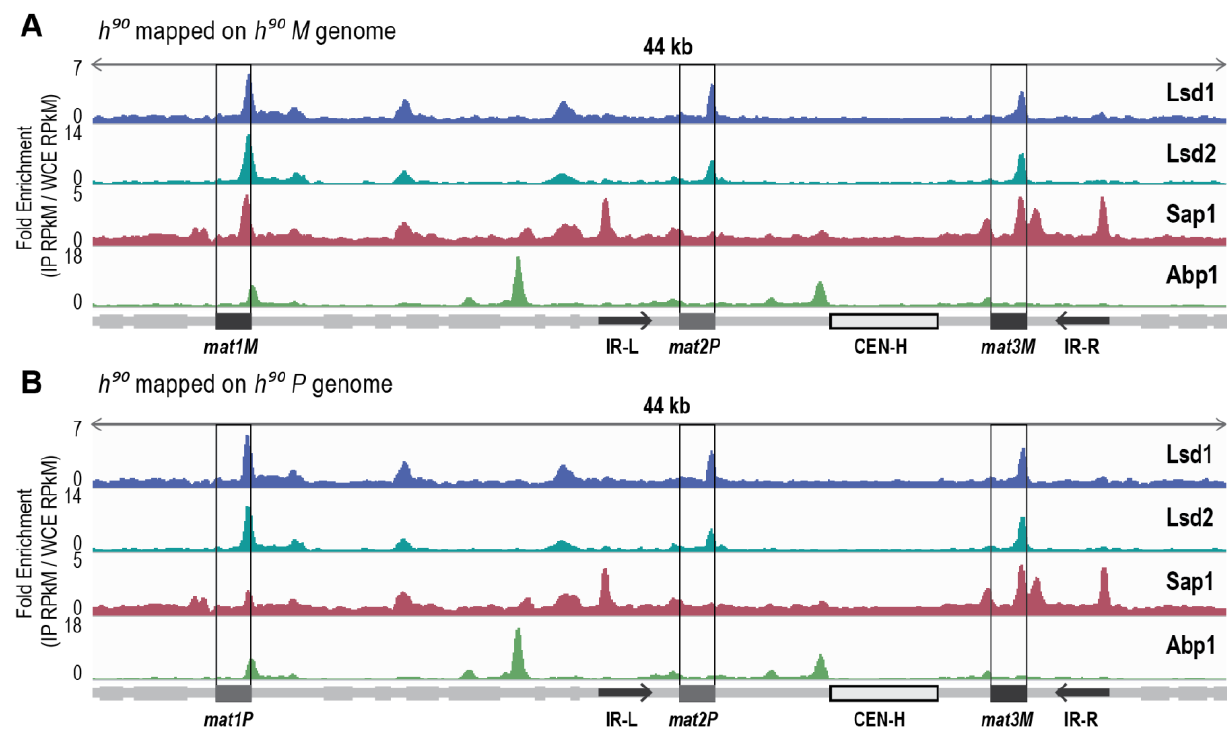
FIGURE 1: Lsd1, Lsd2, Sap1 and Abp1 are recruited to the mating type region. (A) Distribution of normalized enrichments of the Abp1, Lsd1, Lsd2, and Sap1 ChIPs in a h 90 strain (IP RPkM reads per kilobase million / WCE RPkM). The sequence used for the alignment is a 44-kb region that contains the MT region with the M allele at mat1 : h 90 M . The 3 mat loci are indicated as well as the CEN-H region and the inverted re- peats IR-L and IR-R. Light gray boxes show genes present in this region. (B) Same than in A) except that the sequence used for the alignment is a 44-kb region that contains the MT region with the P allele at mat1 : h 90 P